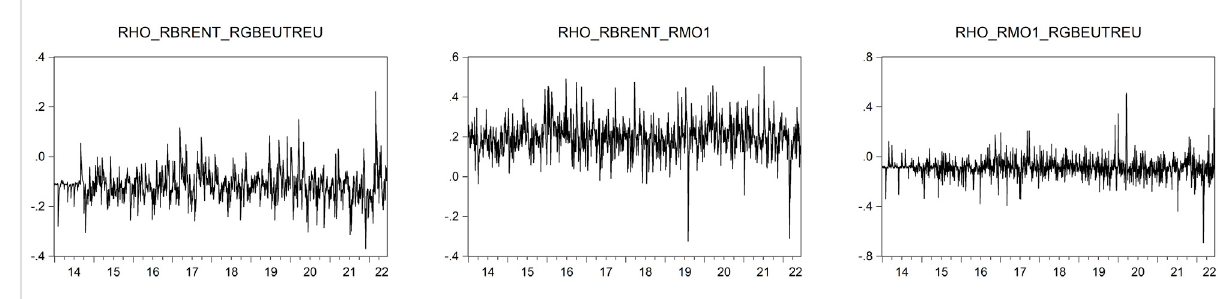
FIGURE 5 Dynamic Correlations among oil brent price return, CO 2 futures returns (RMO1), and Green Bond Index (RGBEUTREU). Source: Authors ’ own research using data from